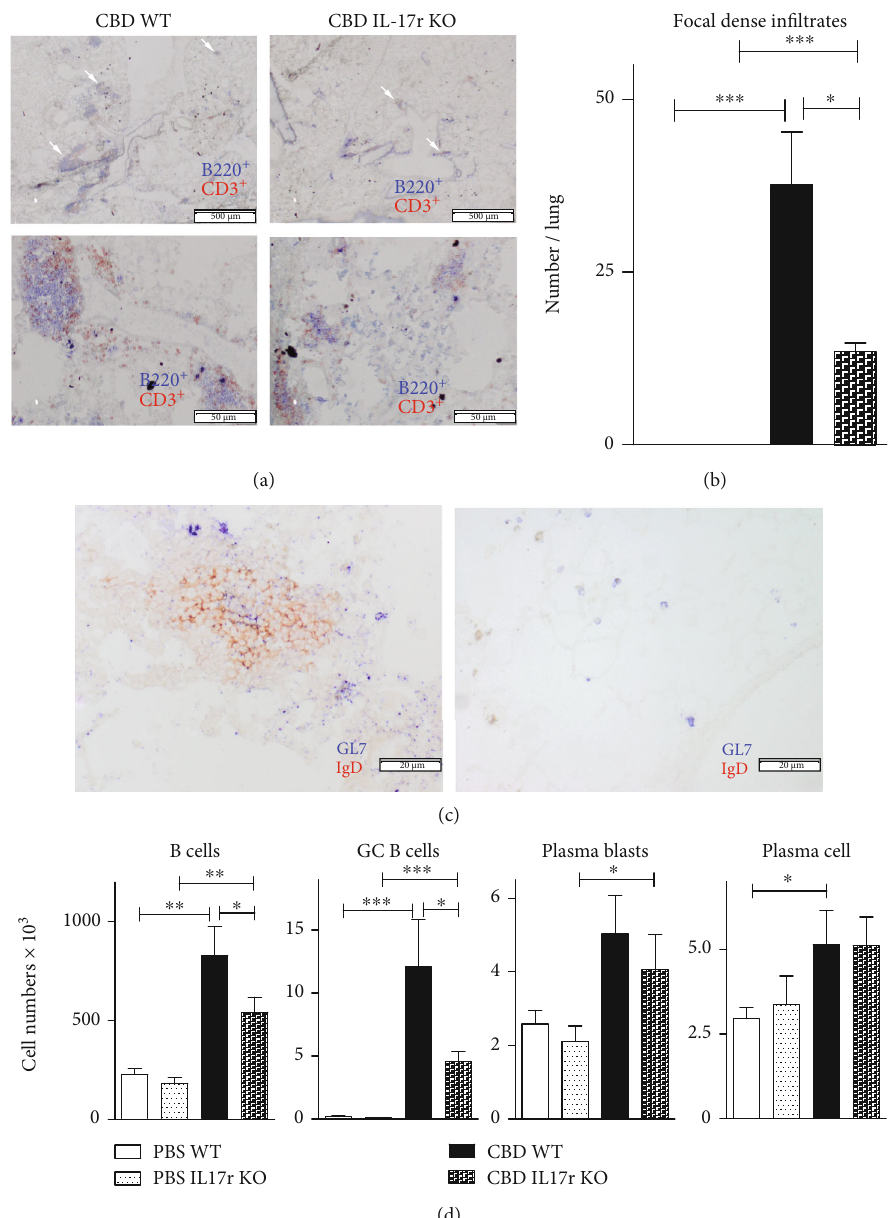
Figure 8: IL-17 signaling is important for TLS formation in CBD pathology. (a) Immunohistochemical analysis of lung tissue sections stained for B220 + B cells (blue) and CD3 + T cells (red) of the lungs obtained from CBD WT and CBD IL-17R KO mice, as indicated, at 8 weeks after Be/BeO exposure. Arrows indicate perivascular focal dense in fi ltrates, re fl ecting TLSs of the lungs of CBD mice. Scale bars: 500 μ m (upper panels) and 50 μ m (lower panels). (b) Quanti fi cation of focal dense in fi ltrates in lung sections of the indicated mice. (c) Immunohistochemical analysis of a lung tissue section for IgD (red) and the GC marker GL7 (blue) from a WT CBD mouse, conforming the presence of a GC in the TLS 20 μ m. (d) Quanti fi cation of fl ow cytometric analyses of the indicated B-lineage populations of single-cell lung digest (d). The results shown are expressed as the means ± SEM and represent one out of two independent experiments with 4-7 mice per group. Mann-Whitney U test: ∗ p < 0 : 05 , ∗∗ p < 0 : 01 , and ∗∗∗ p < 0 : 001